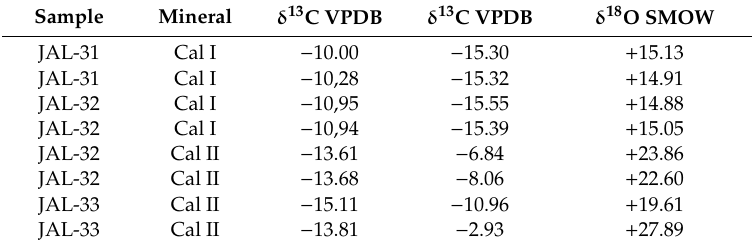
Table 6. Stable isotope values (in ‰) of the two calcite generations (Cal I) and (Cal II) from different samples at Savda.